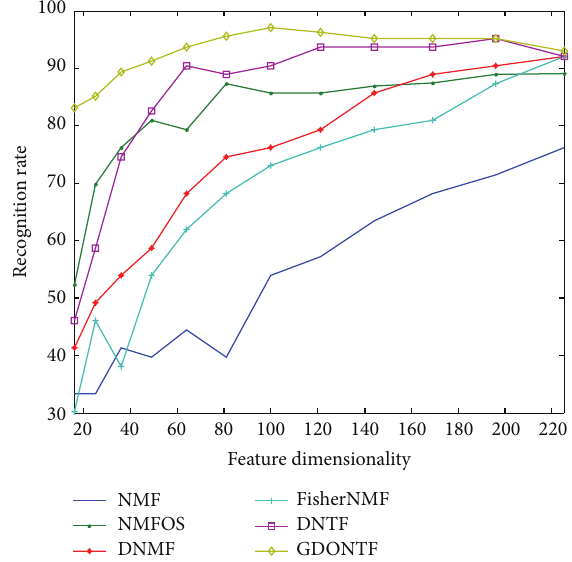
Figure 2: Facial expression recognition rate versus dimensionality in Jaff